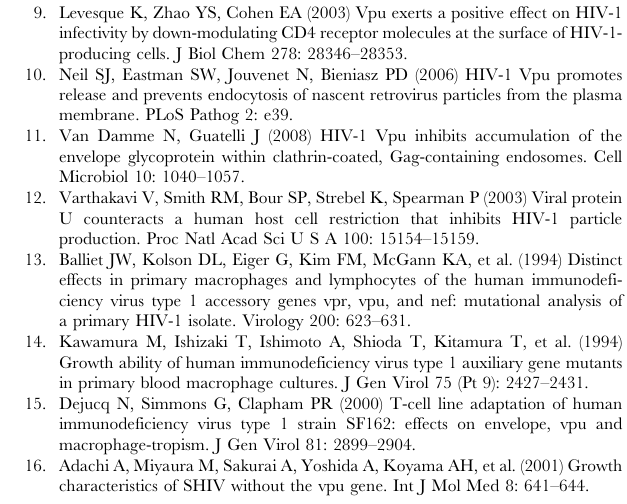
Figure S1 Infectivity of VSV-G pseudotyped viruses. VSV-G pseudotyped viruses were made by co-transfecting 293T cells with VSV-G plasmid and following plasmids (WT, D Vpu, L30E and L30E- D vpu). Progeny pseudovirions were harvested at 48 h, clarified by centrifugation (2000 rpm for 5 min), filtered through 0.45 m m pore size syringe filter and tested for infectivity in GHOST-CD4-CXCR4 cells. (A) Viruses were serially diluted and equal amount of supernatant was added on GHOST-CD4- CXCR4 cell plated in 96-well plate (10,000 cells/well). As positive infectivity control, pNL4.3 virus without VSV-G was added and as negative control pNL-AD8 virus without VSV-G was added on GHOST-CD4-CXCR4 cells. 48 h post-infection, GHOST cells were fixed with acetone-methanol (1:1 ratio) and immunostained for p24 antigen. Blue cells represent focus forming units (FFU) or infectious units. (B) Blue cells were counted as infectious units, their average was calculated per millilitre and plotted in a